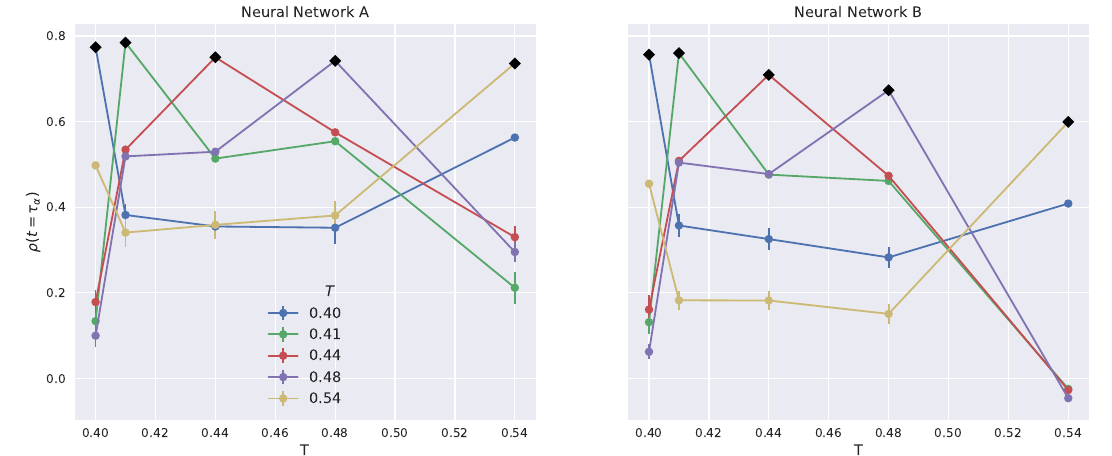
Figure 7. Performance of the NN prediction at t = τ α for temperatures being different from the training one. The training temperature is marked with black diamonds on the